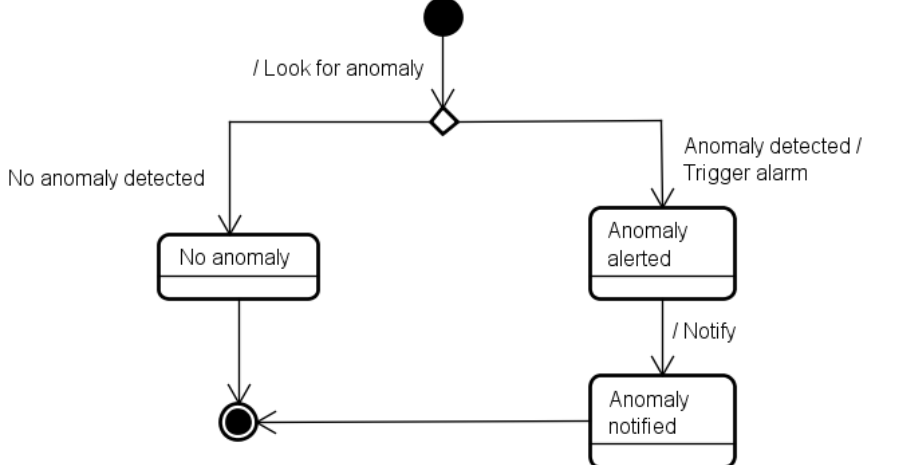
Figure 2. The state-transition machine showing the possible states for an